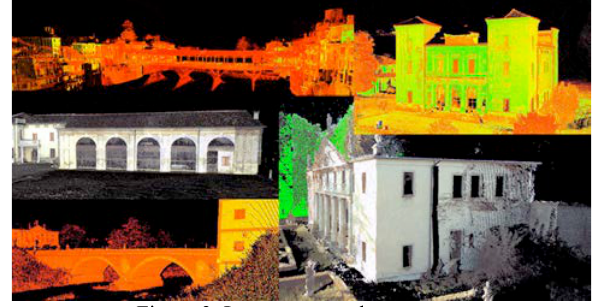
Figure 3. Laser scanner data capture.